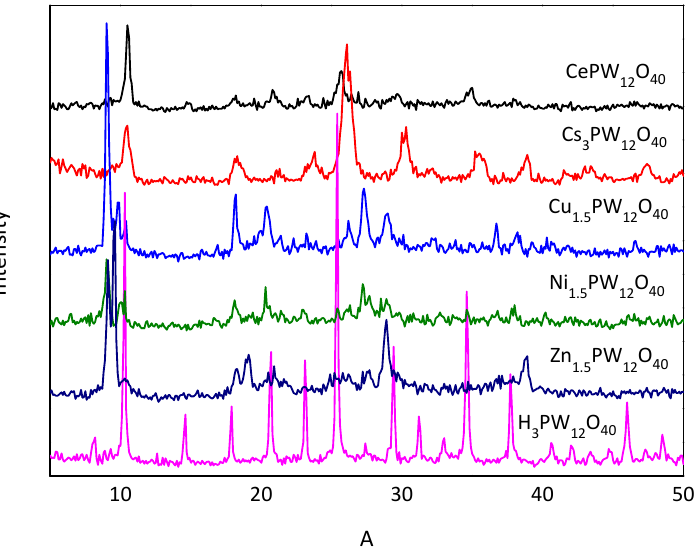
Figure 1. XRD patterns of heteropolyacid salts.